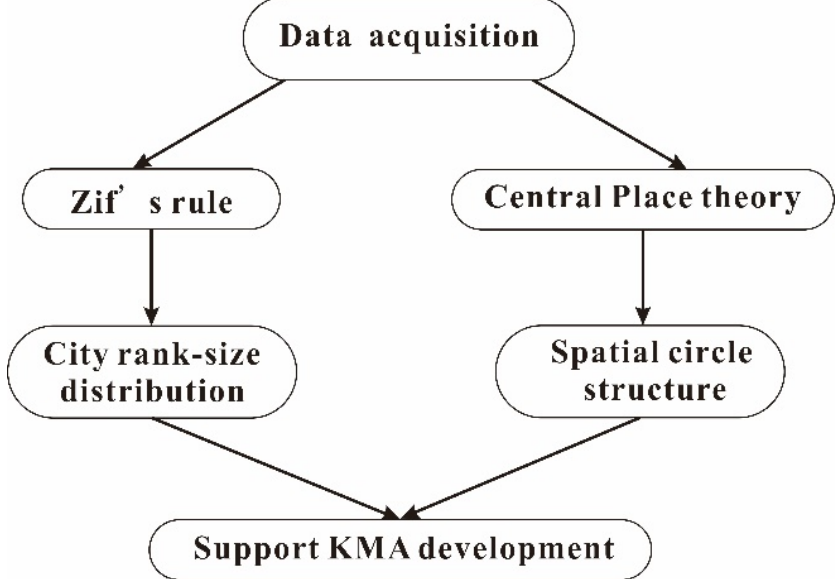
Figure 2. The conceptual framework of spatial structure in KMA.